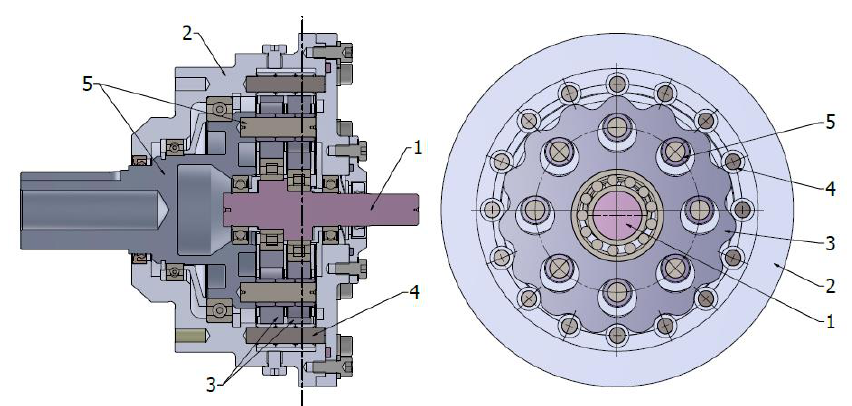
Figure 1. Cycloidal gear: 1 — input shaft, 2 — housing, 3 — cycloidal discs, 4 — outer pins with sliding sleeves, 5 — output shaft with inner pins and sliding sleeves.